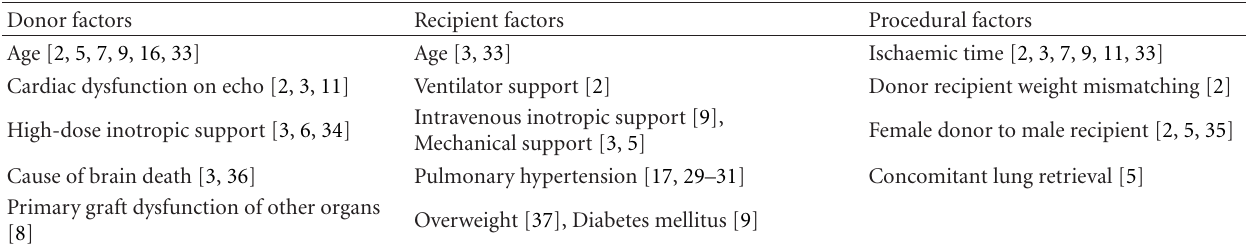
Table 2: Risk factors for primary graft